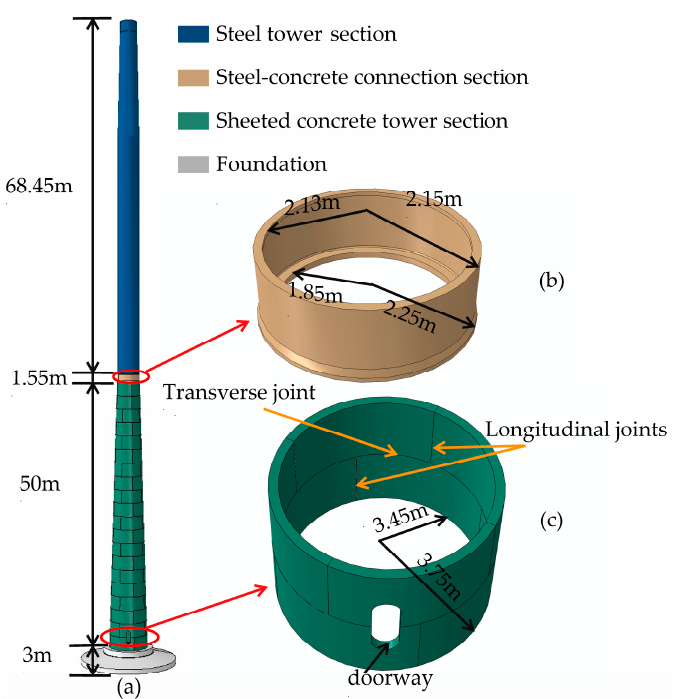
Figure 1. Model of the tower’s geometric parameters. ( a ) Model of steel-concrete wind turbine tower; ( b ) Steel-concrete connection section; ( c ) Concrete pieces of 1st and 2nd sections.